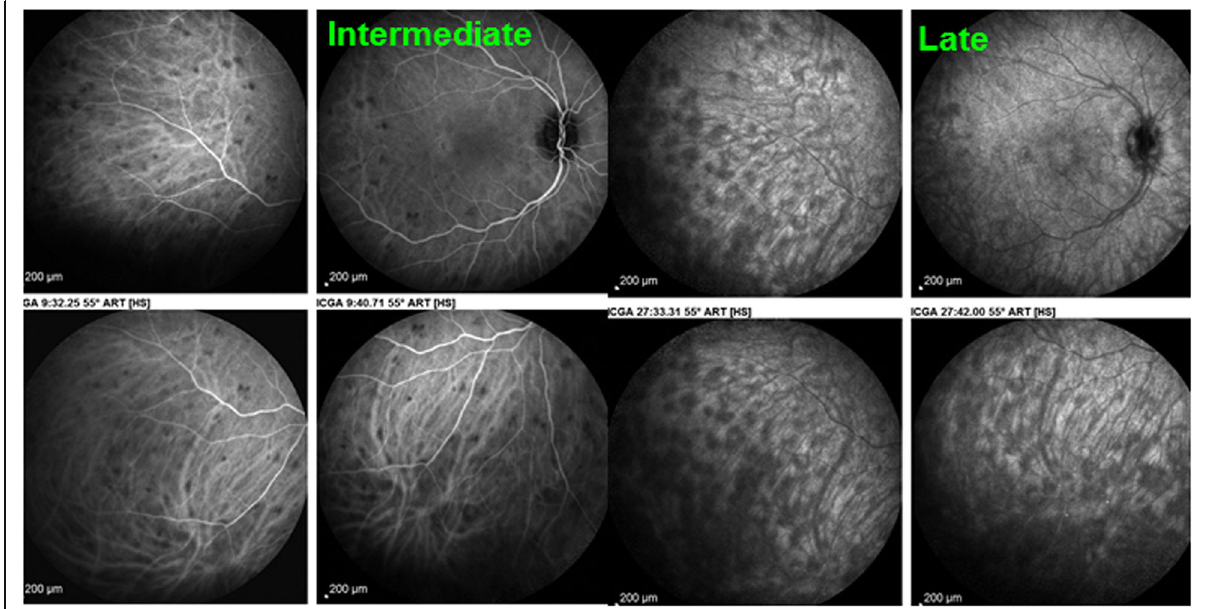
Fig. 6 Indocyanine green angiography (ICGA), type 2 pattern found in stromal choroiditis. Typical round HDDs of similar size evenly distributed caused by the presence of inflammatory foci that impair the diffusion of the ICG dye showing granulomas in negative in a case of Vogt- Koyanagi-Harada disease (VKH). HDDs are more clearly delineated in the late angiographic phase (right quartet) than in the intermediate phase (left